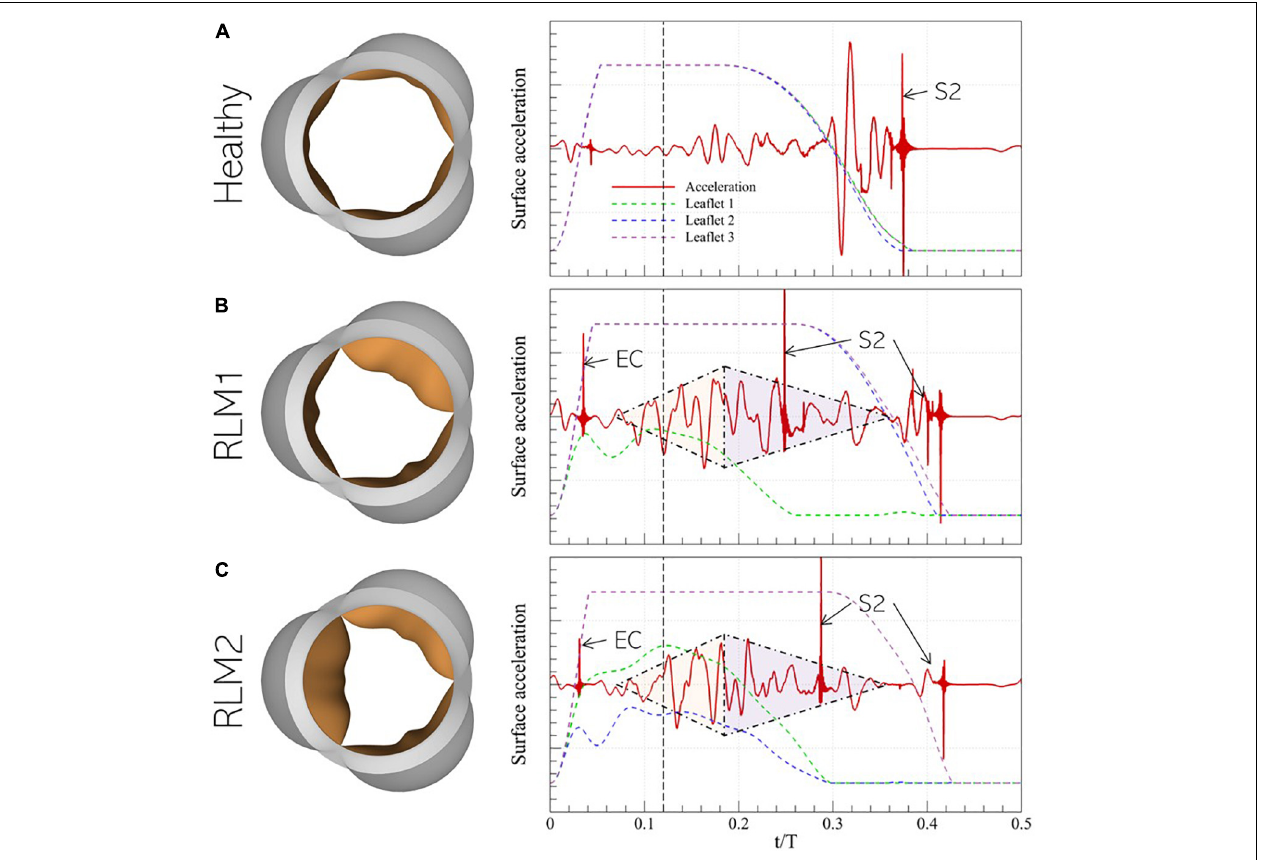
FIGURE 8 | (left) Peak systolic valve configuration and (right) systolic surface acceleration measurement at the monitor point in the representative (A) Healthy, (B) RLM1, and (C) RLM2 cases. The colored dashed lines show instantaneous displacement of the three leaflets in each case and the vertical dashed black line denotes the instant of peak systole. Key instances of systolic heart sounds are also indicated: EC- ejection click, S2- “dub”/second heart sound, shaded triangles are used to mark the crescendo/decrescendo of the stenotic valve